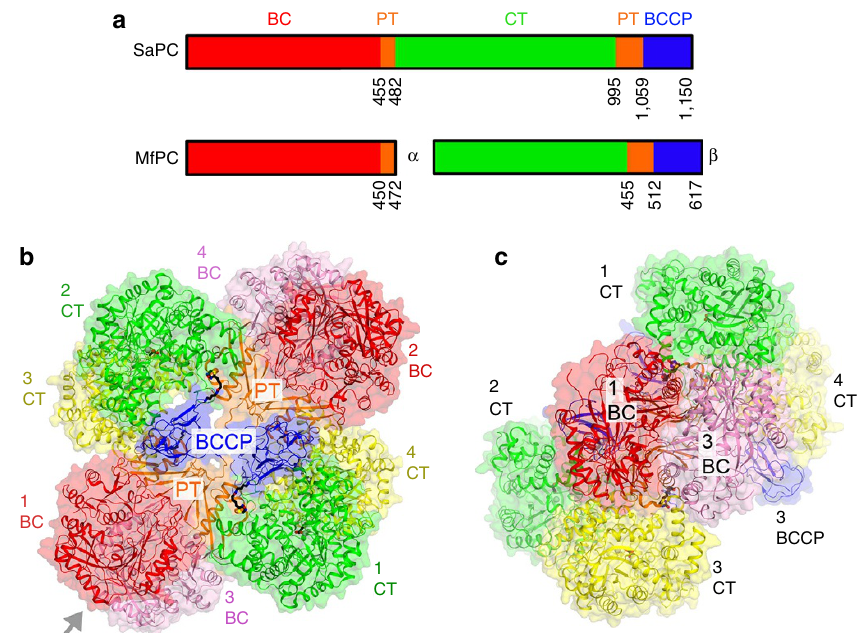
Figure 1 | Domain organization of PC. ( a ) Domain organization of single-chain SaPC and two-subunit MfPC. The domains are labelled and given different colours. ( b ) Schematic drawing of the structure of the single-chain SaPC holoenzyme 9 . The domains in the four monomers are coloured according to a and labelled. ( c ) Structure of SaPC viewed down the two-fold axis of the BC dimer, along the arrow of b . The structure figures were produced with PyMOL